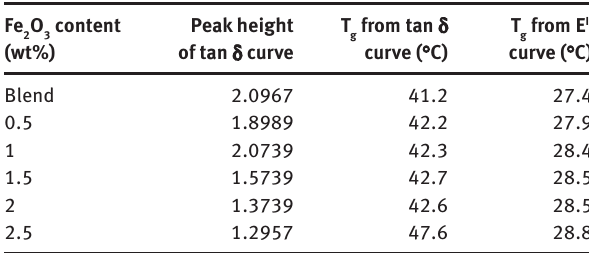
from tan δ curve and E II g